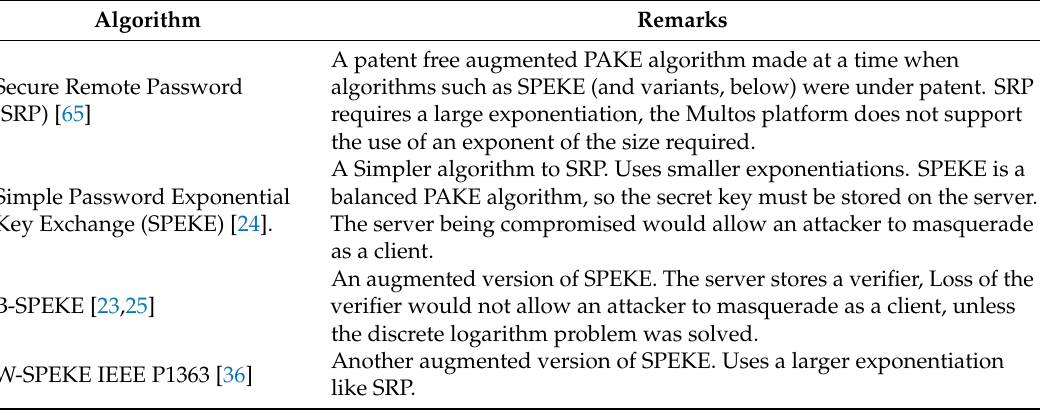
Table 10. Choice of algorithms for PAKE